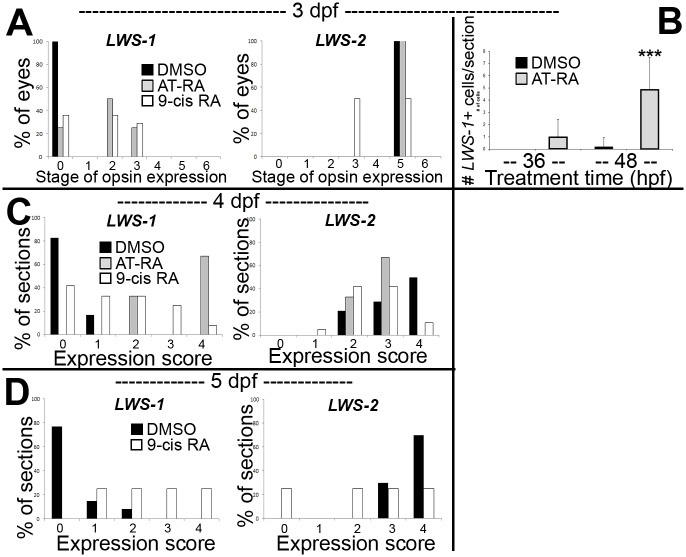
Quantitative analysis of expression patterns of LWS1 and LWS2 in response to all-trans RA (at-RA) or 9-cis RA treatment.A. Scoring of LWS1 and LWS2 expression in whole mounted eyes of embryos treated from 48 hpf to 75 hpf; stages of opsin expression are described in Materials and Methods. B. Numbers of LWS1- and LWS2-expressing cells in the outer nuclear layers of cryosections derived from embryos treated with at-RA from 36 hpf to 75 hpf as compared to treatments from 48 hpf to 75 hpf; ***, p<0.001). C. Scoring of LWS1 and LWS2 expression domains in the outer nuclear layers of cryosections derived from embryos treated with at-RA or 9-cis RA from 48 hpf to 4 dpf. D. Scoring of LWS1 and LWS2 expression domains in the outer nuclear layers of cryosections derived from embryos treated with 9-cis RA from 48 hpf to 5 dpf (C). Expression scores are described in Materials and Methods; statistical analyses (Fisher’s Exact Test) in Table 6.